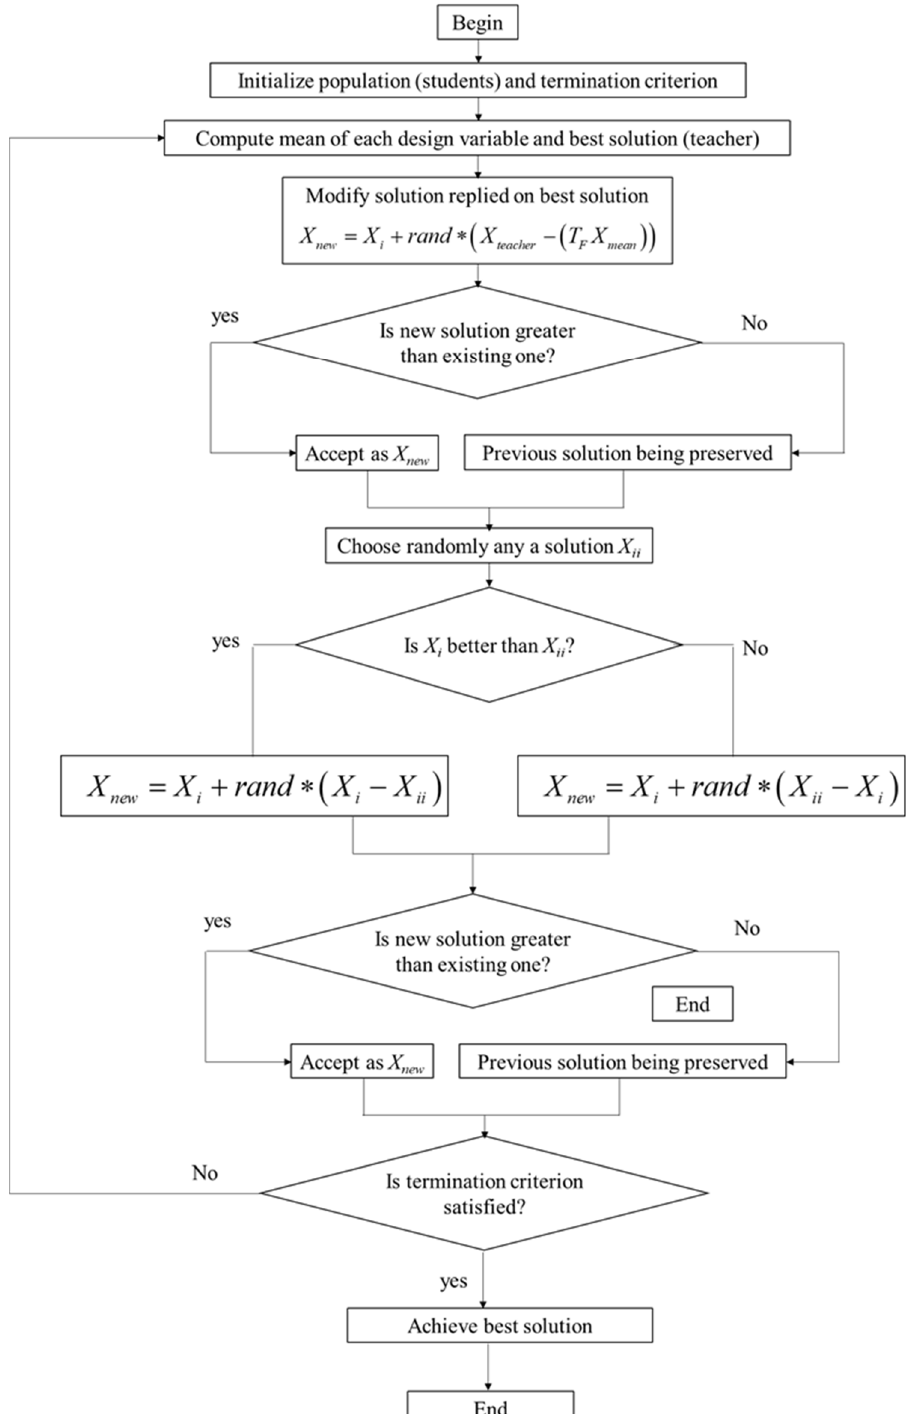
Figure 13. Flowchart of